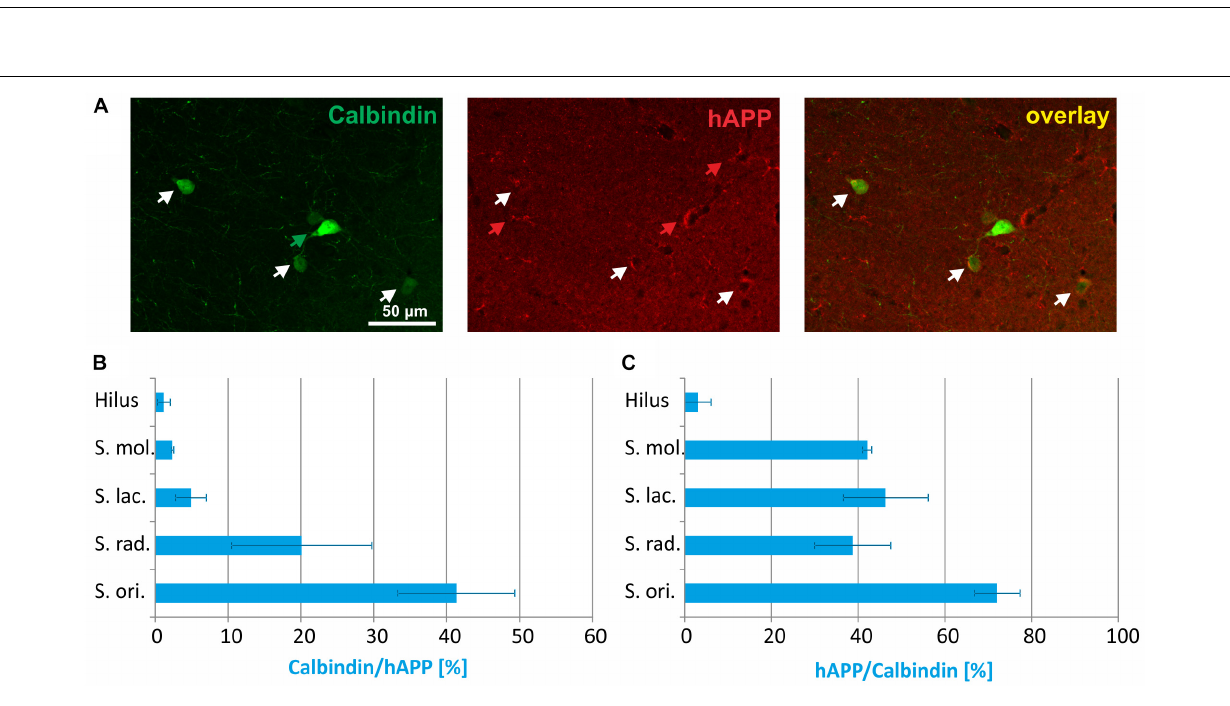
FIGURE 3 | Quantitative analyses of the co-localization between calbindin-immunoreactive neurons and hAPP-expressing interneurons in hippocampus of Tg2576 mice. Typical examples of double labelings in stratum radiatum are shown in panel (A) . White arrows point to double-labeled neurons, green, and red arrows to neurons that are only labeled by green (calbindin) and red (hAPP) fluorescence, respectively. Quantitative analysis revealed that of all hAPP transgene-expressing interneurons 2% (in DG hilus) to 42% (in stratum oriens ) were calbindin-immunoreactive (B) . Of all calbindin-expressing neurons, 5 to 70% expressed the hAPP transgene (C)